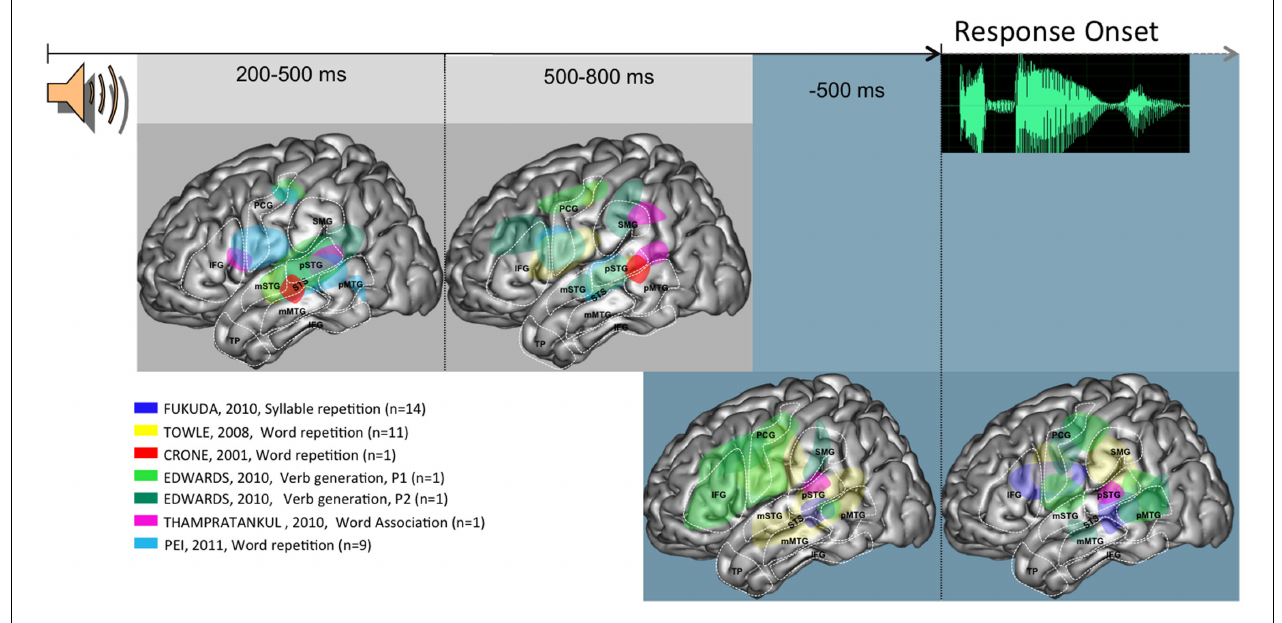
“Overview of the Spatio-Temporal Dynamics Uncovered” in the General Discussion. Abbreviations used: IFG, inferior frontal gyrus; STS, superior temporal sulcus; SMG, supra marginal gyrus; pSTG, posterior part of the superior temporal gyrus; mSTG, middle part of the superior temporal gyrus; pMTG, posterior part of the middle temporal gyrus; mMTG, middle part of the middle temporal gyrus; PCG, pre central gyrus;TP, temporal